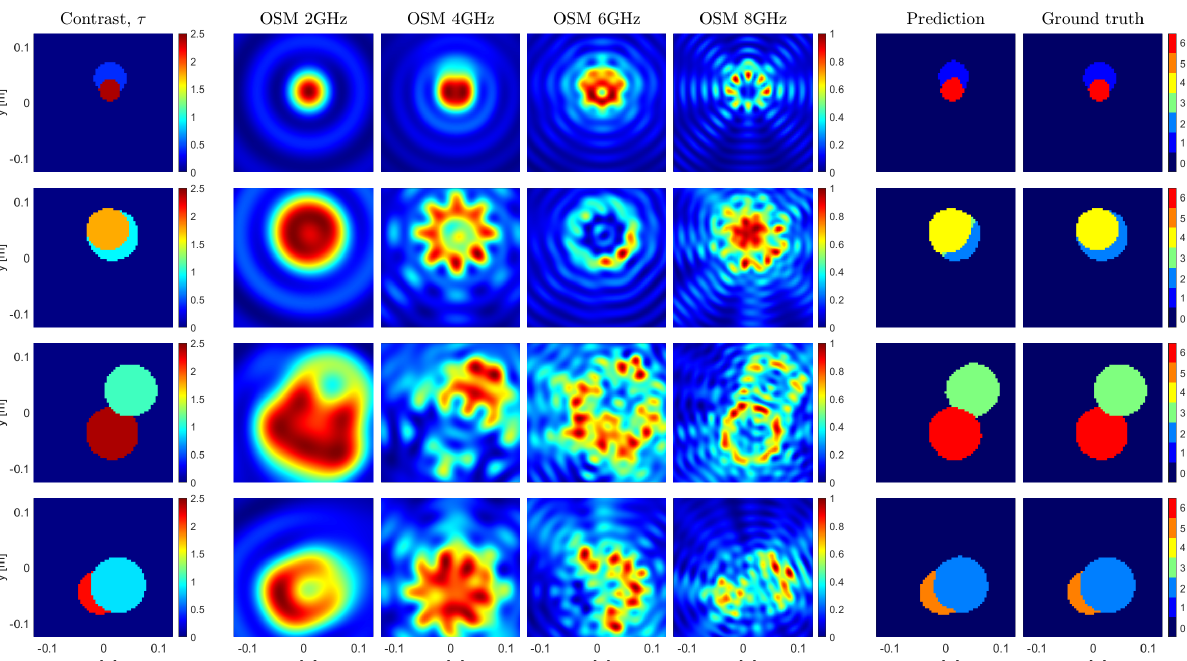
Figure 3. Imaging results of 4 test samples. One sample per row, with the first column representing the targets with their dielectric properties. The following 4 columns show 4 out of 8 single-frequency OSM indicators at 2, 4, 6, and 8 GHz. The 6th and 7th columns depict the segmented contrast prediction made by the U − Net and the ground truth segmented contrast map,